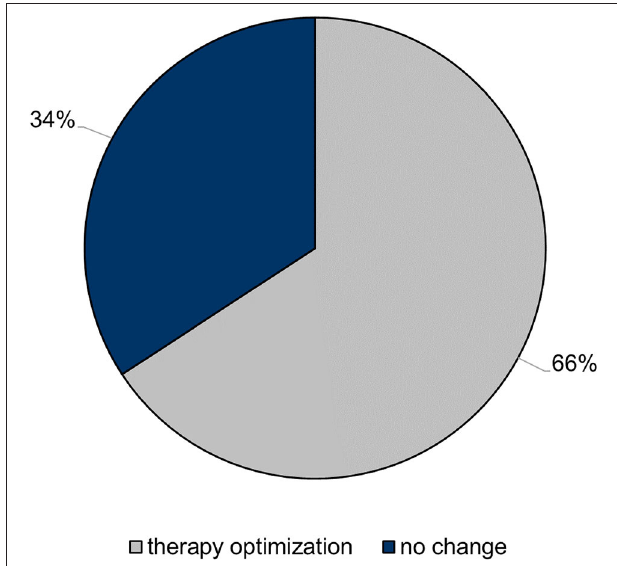
FIGURE 1 | Impact of follow-up coronary CT angiography on patient management. In a relevant proportion of the study population, the therapeutic regimen was adjusted due to the results of the follow-up coronary CT